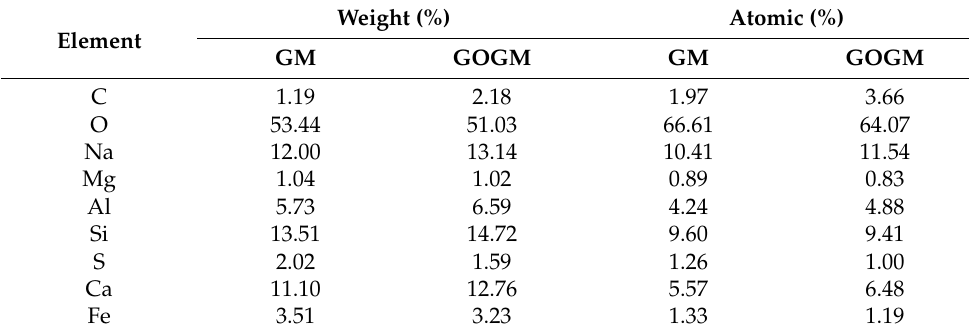
Table 6. Elemental analysis with EDS.